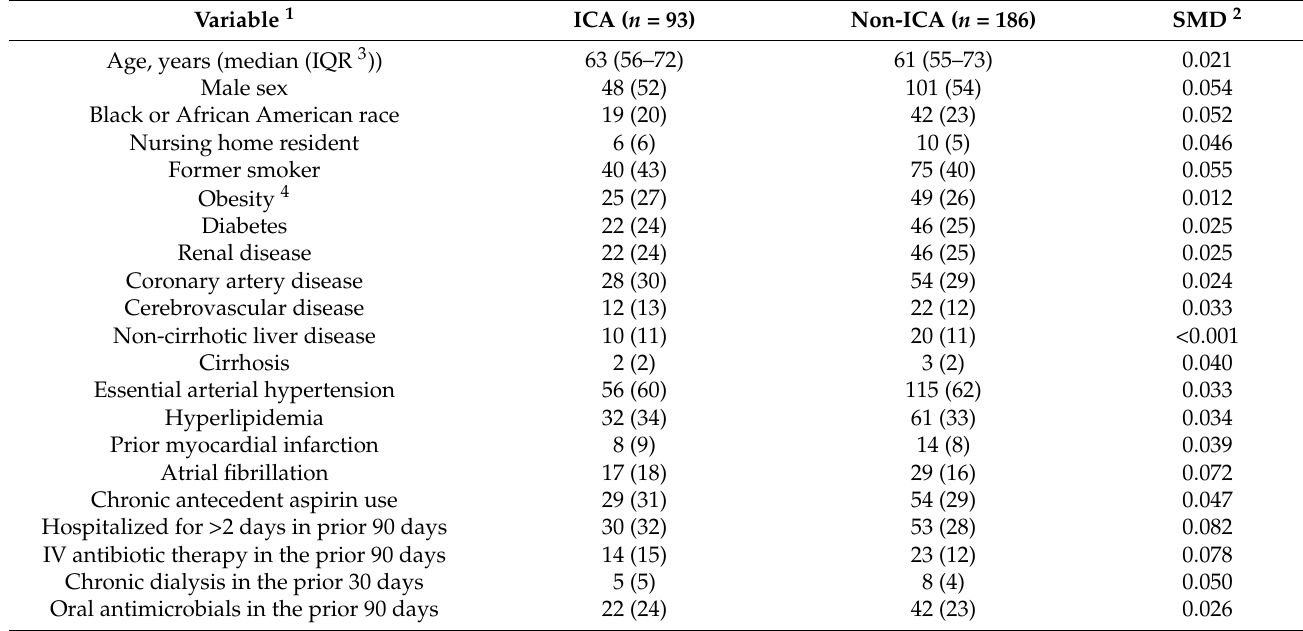
Table 1. Patient characteristics of immunocompromised adult cases and non-immunocompromised adult controls after propensity score matching.